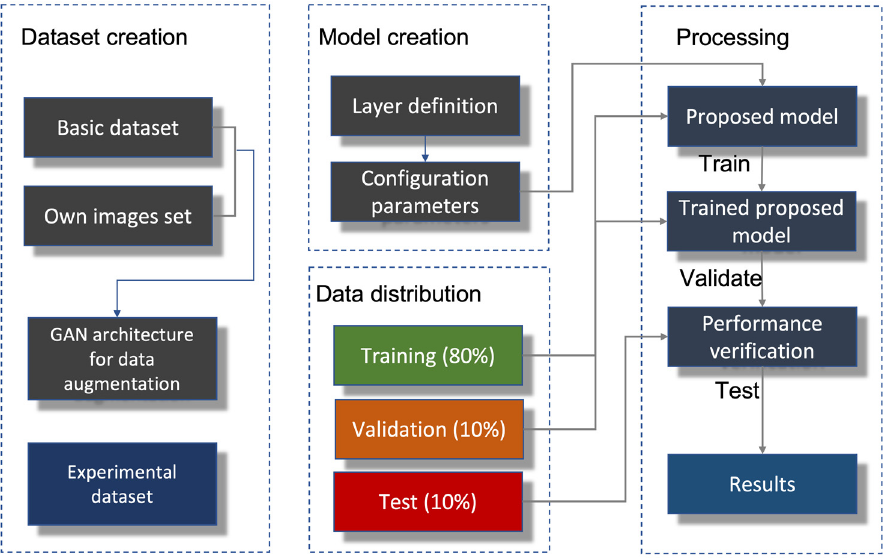
Figure 2. Representation of the proposed architecture for tomato disease detection.